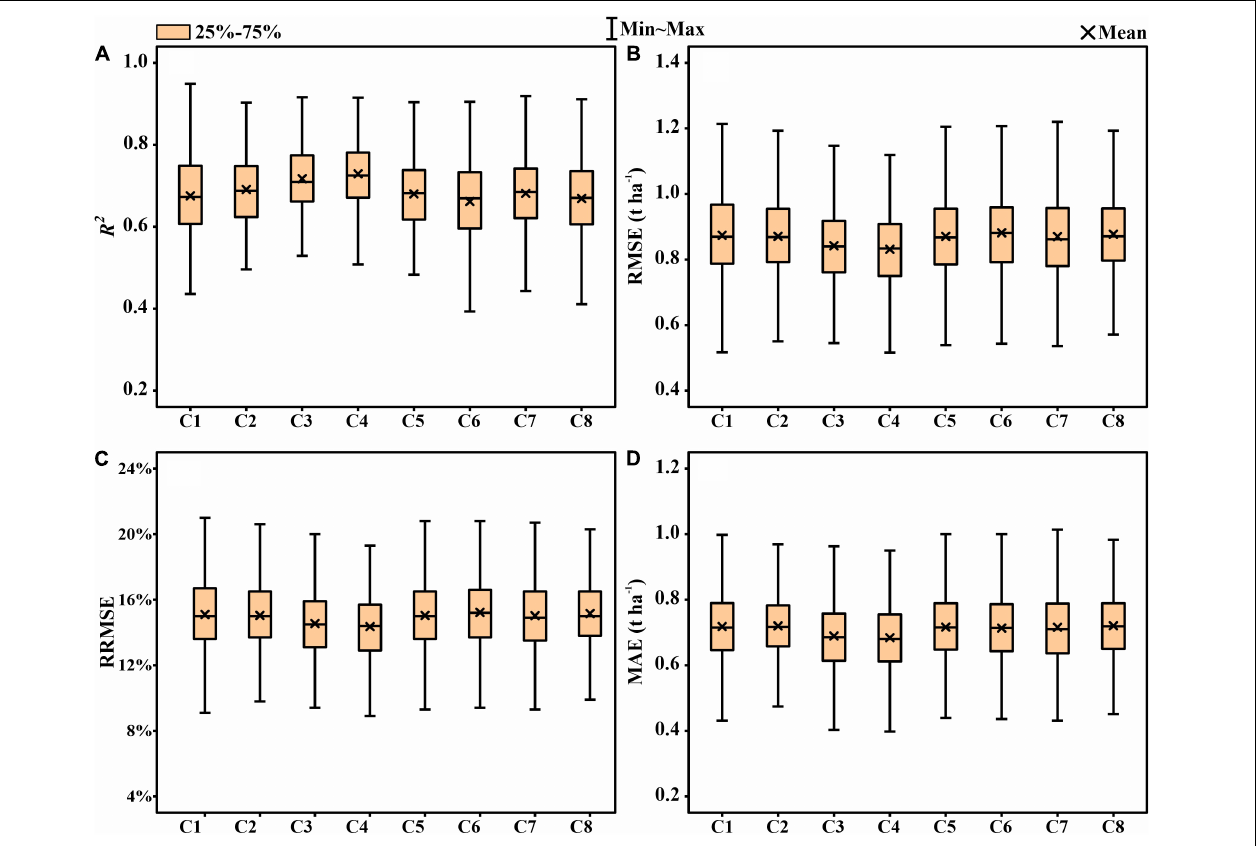
FIGURE 8 | Statistical distributions of (A) R 2 , (B) RMSE, (C) RRMSE, and (D) MAE of the ENR model that uses both multispectral and thermal features from different stages as